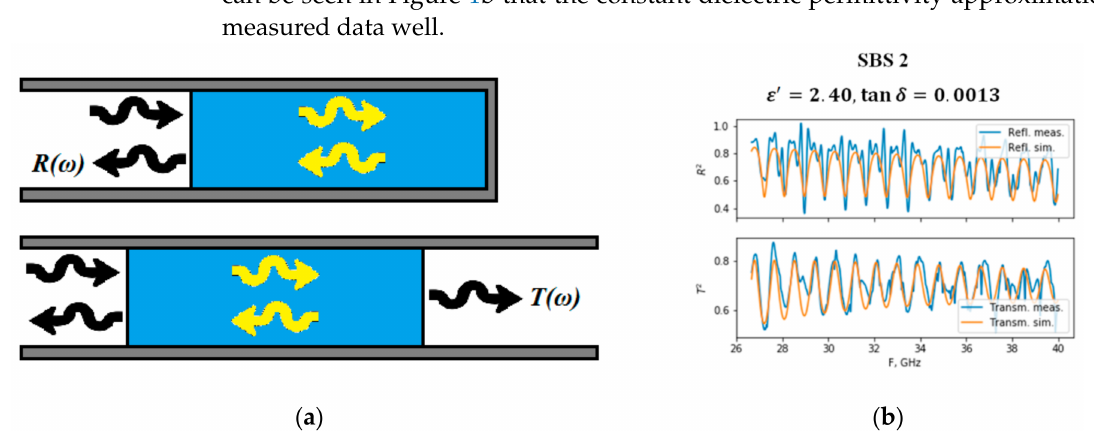
Figure 1. ( a ) The scheme of measurement of the reflection and transmission coefficients with the test sample in the form of the waveguide insert 7.2 mm × 3.4 mm × 100 mm ( a ); ( b ) comparison of the measurement results and simulation data for SBS plastic in the frequency range 26–40 GHz.